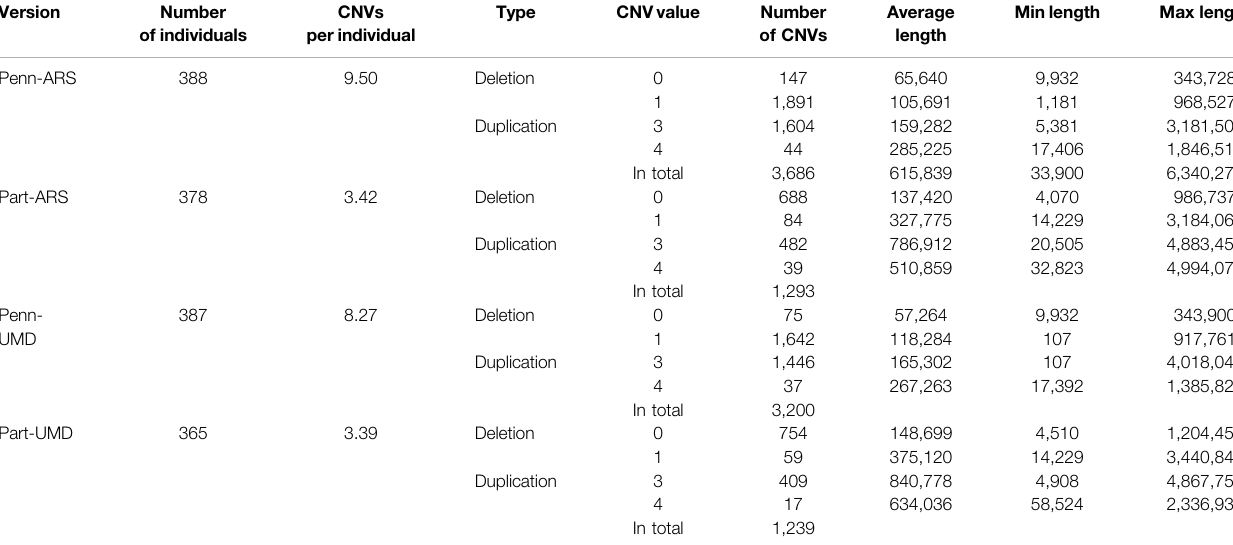
TABLE 2 | Statistical description of copy number variant (CNV).